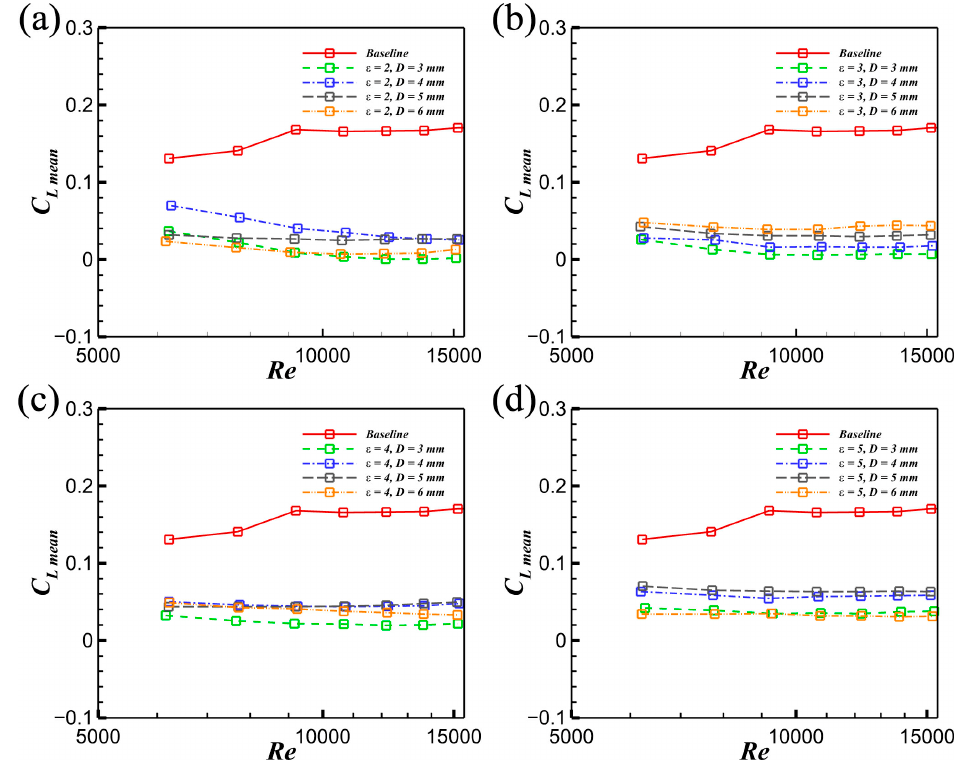
Figure 17. ( a – d ) The relationship between the time-averaged lift force coefficient and the Reynolds number at different spacing ratios and cylinder diameters.